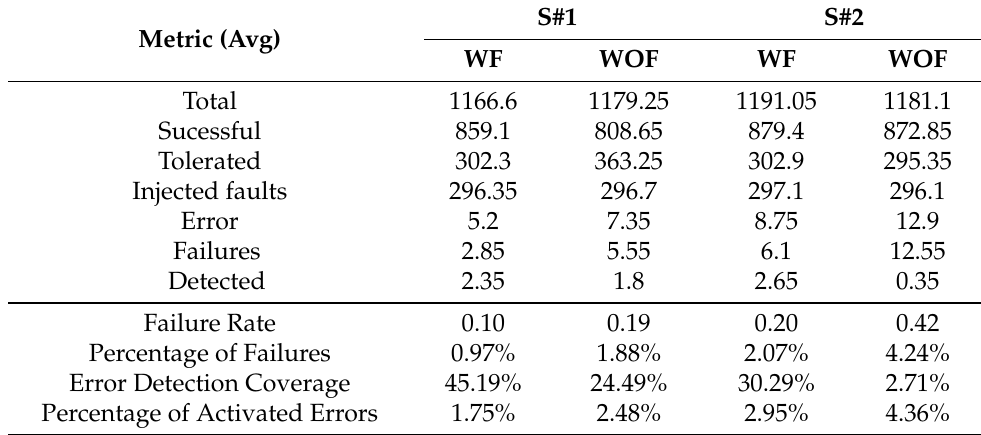
Table 7. Reliability